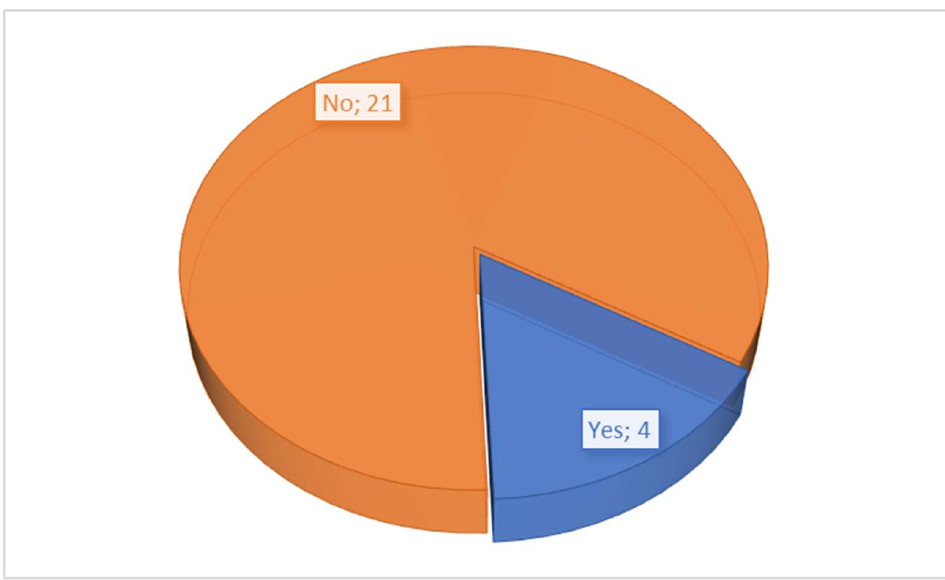
Figure 10. Sharing of data by operators of shared mobility services.